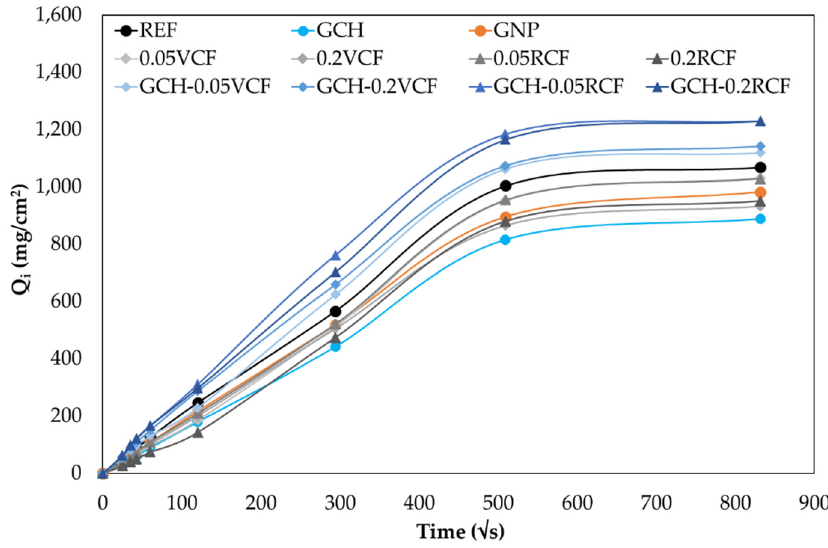
Figure 12. Water absorbed per unit area (Q i ) by mortars after 28 days of curing.